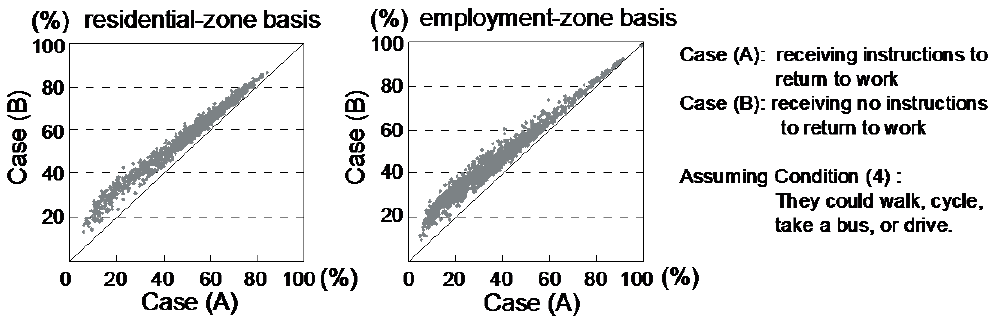
Figure 12. Percentages of commuting difficulty according to residential and employment zones and based on reception/non-reception of instructions to return to